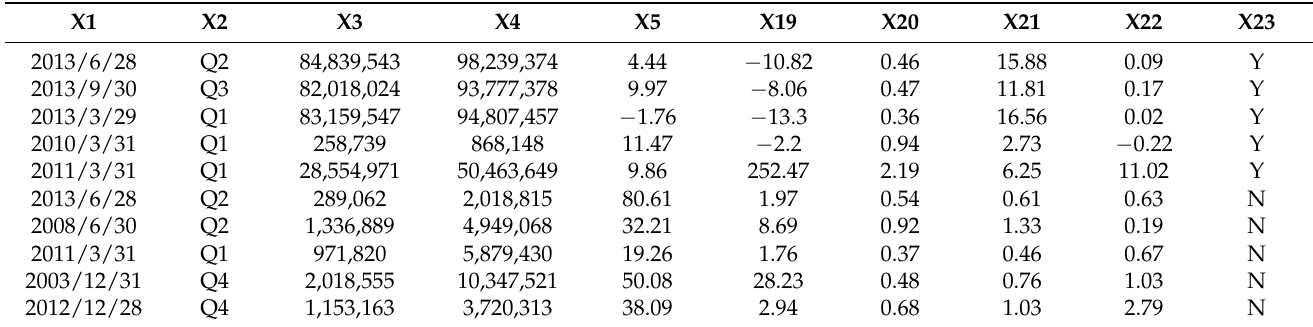
Table 3. Information of the original data related for 491 normal and 491 bankrupt companies.